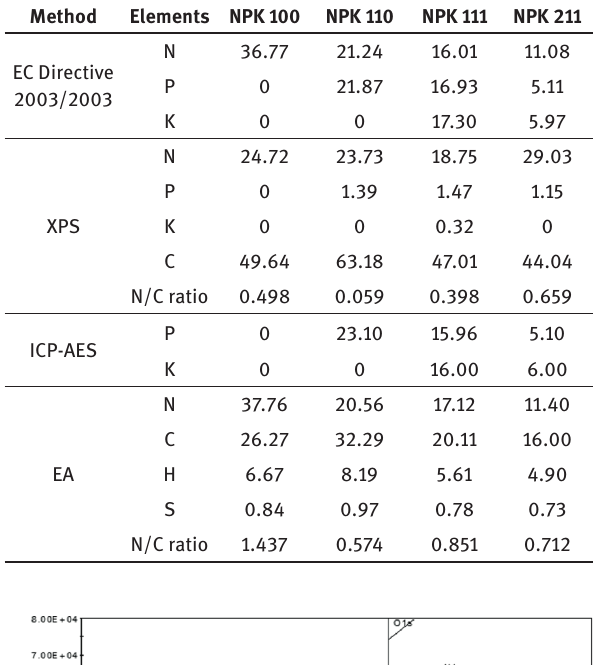
Table 1: Elemental composition.